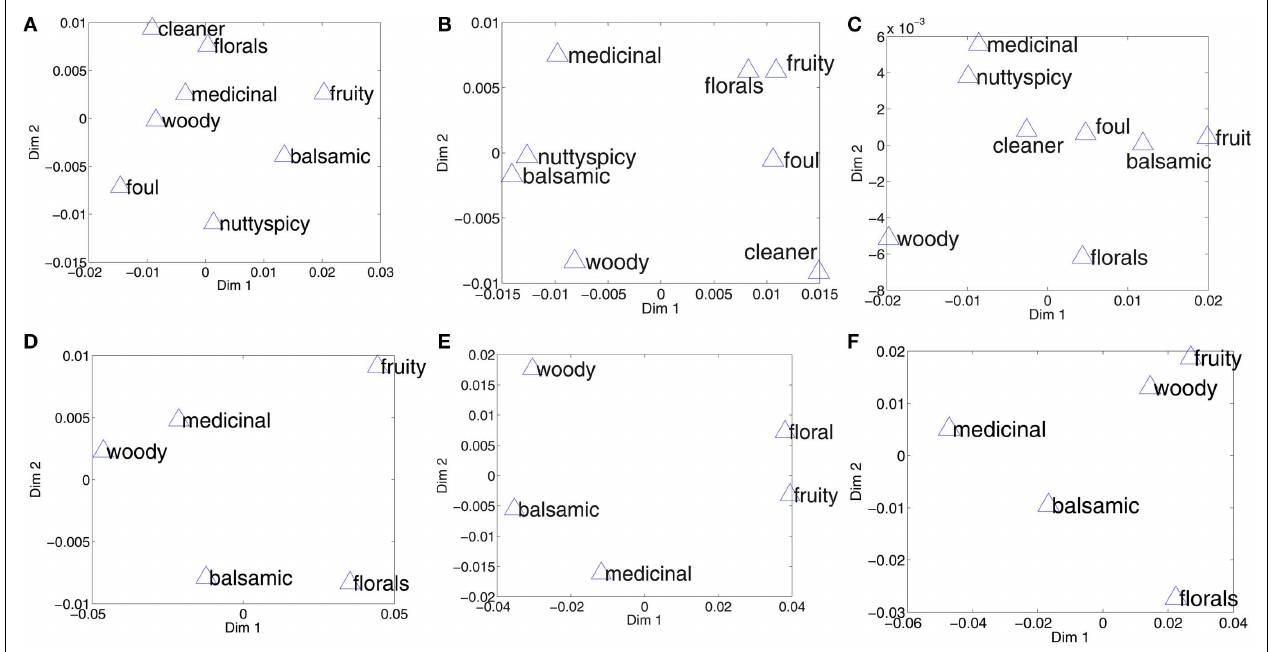
by distances between activations of the entire glomerular layer, independent of spatial arrangement of glomeruli.The lower panel compares the perceptual space, (D) for the BH small data set, and the distances between the categories in the spatial encoding, (E) , and the population encoding, (F)